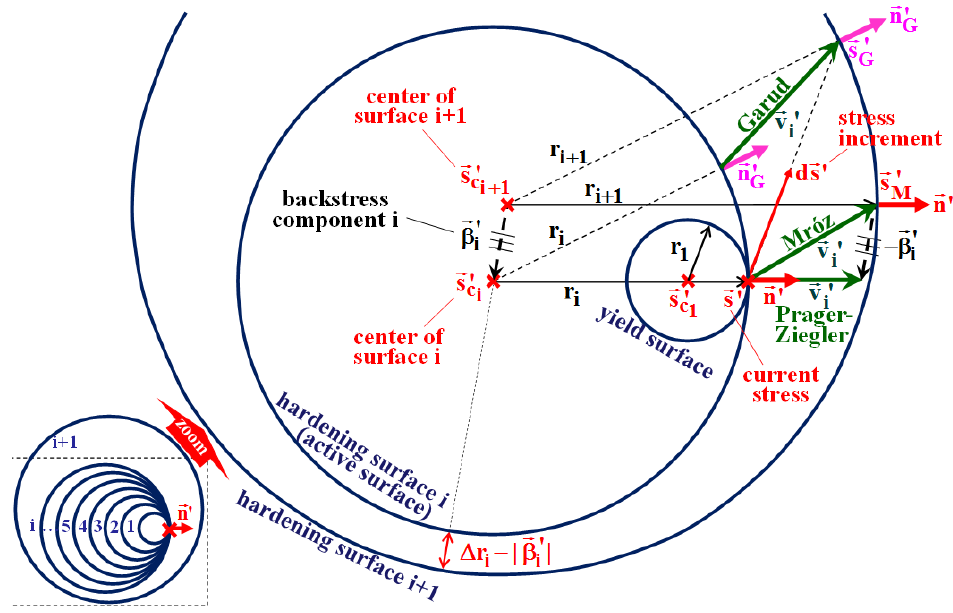
Figure 3: Illustration of Mróz, Garud, and Prager-Ziegler surface translation rules used to model kinematic hardening in the Mróz multi-surface formulation in the E 5s